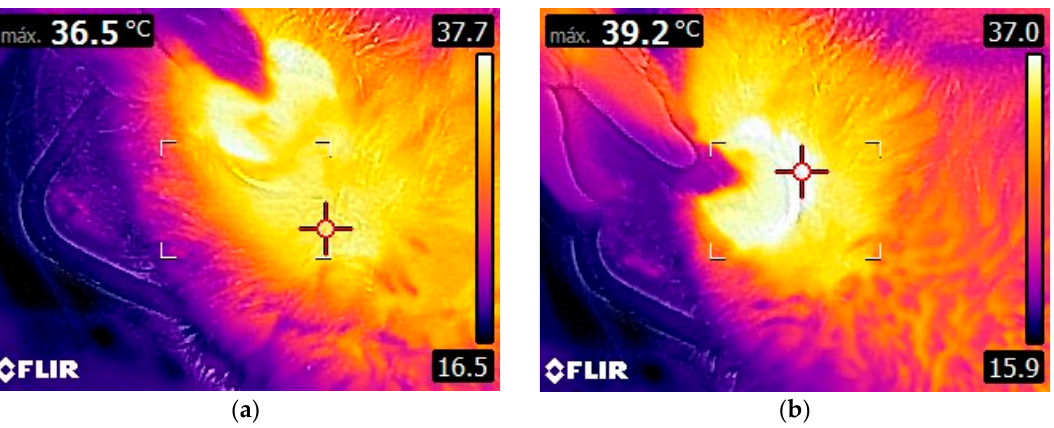
Figure 5. This figure shows the range of surface temperatures during the CRet treatment: ( a ) treated surface (36.5 °C); ( b ) zone closest to the active electrode (39.2 °C), demonstrating thermal comfort during use.